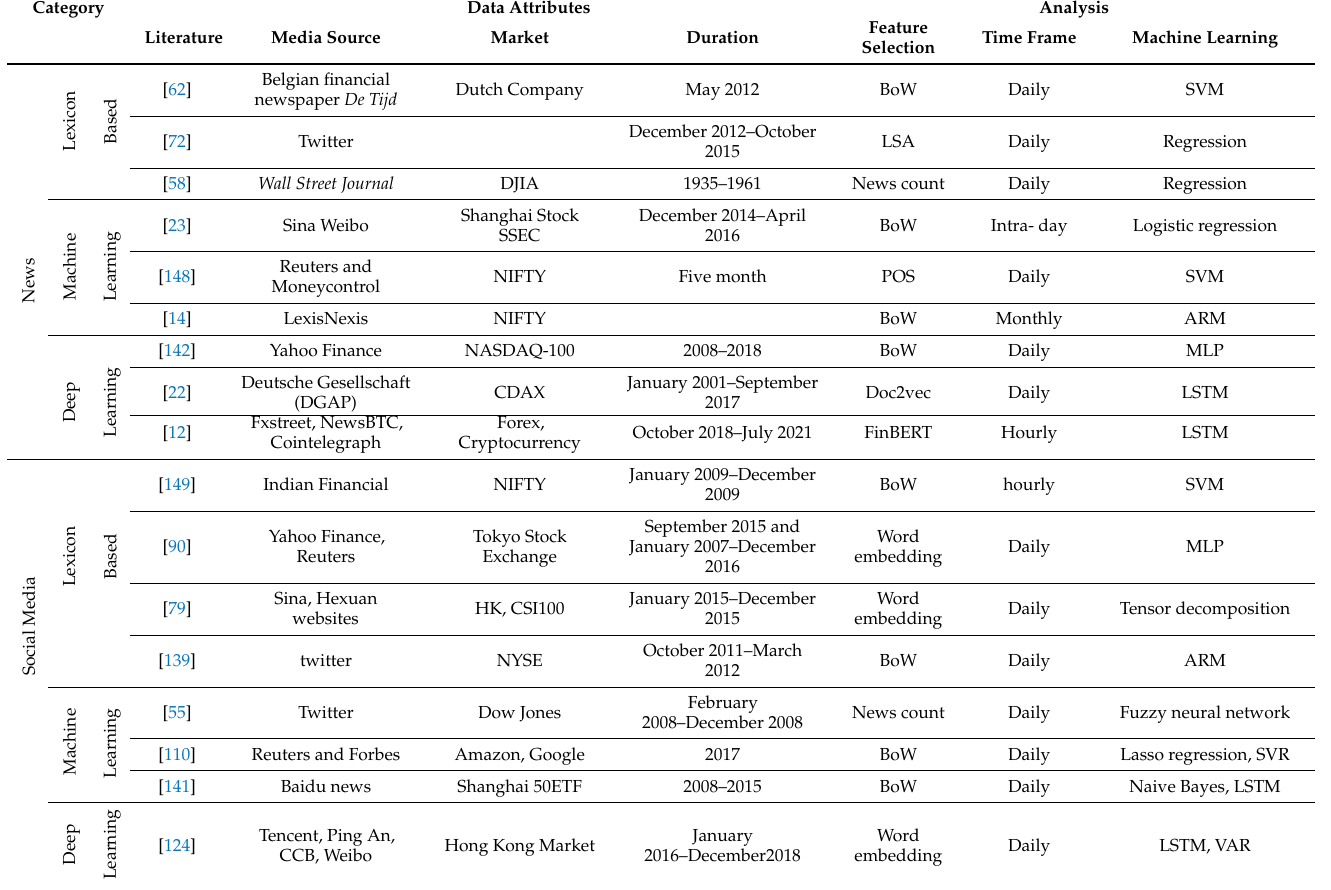
Table 3. Comparison of news and social media sentiment analysis